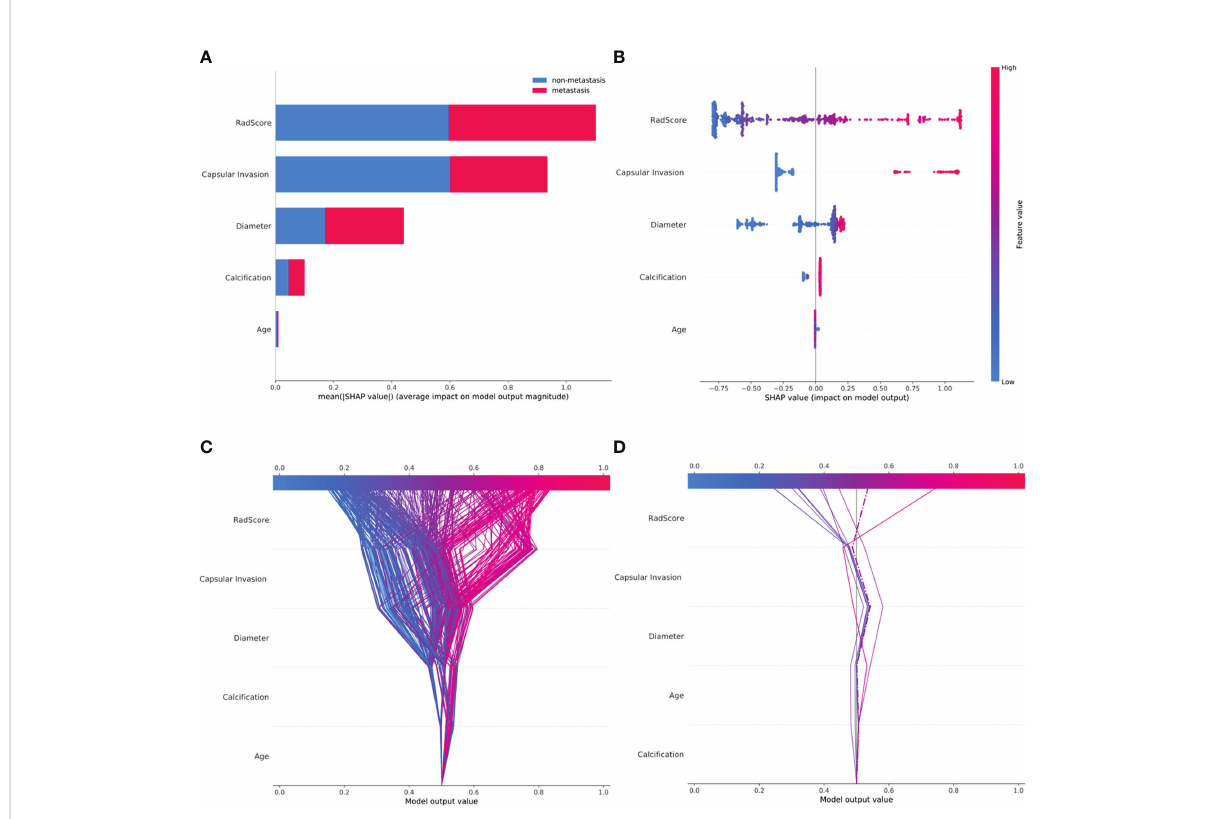
FIGURE 5 SHAP plots of the XGBoost model. (A) The classi fi ed bar charts of the SHAP summary plots show the in fl uence of each parameter on the XGBoost model. (B) The SHAP summary plot ’ s scatter plot shows the relationship between the characteristic value and the predicted probability through colors, including positive and negative predictive effects. (C) SHAP decision plot for all patients with PTC; (D) SHAP decision plot for 10 random patients with PTC, with one misjudgment case (dotted